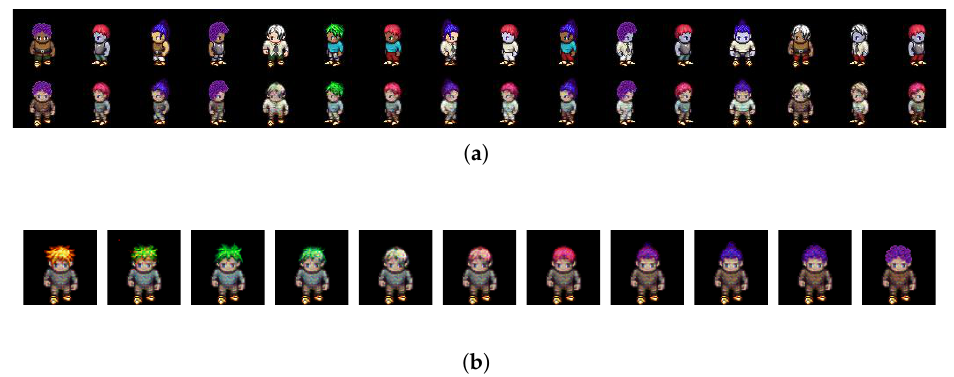
Figure 7. Results on sprite dataset . ( a ) Comparison between input sprite images (first row) and reconstructed ones (second row). ( b ) Images generated fixing all the latent variables’ dimensions but one, which is varied. Generated sprites have fixed attributes but a continuously varying hair